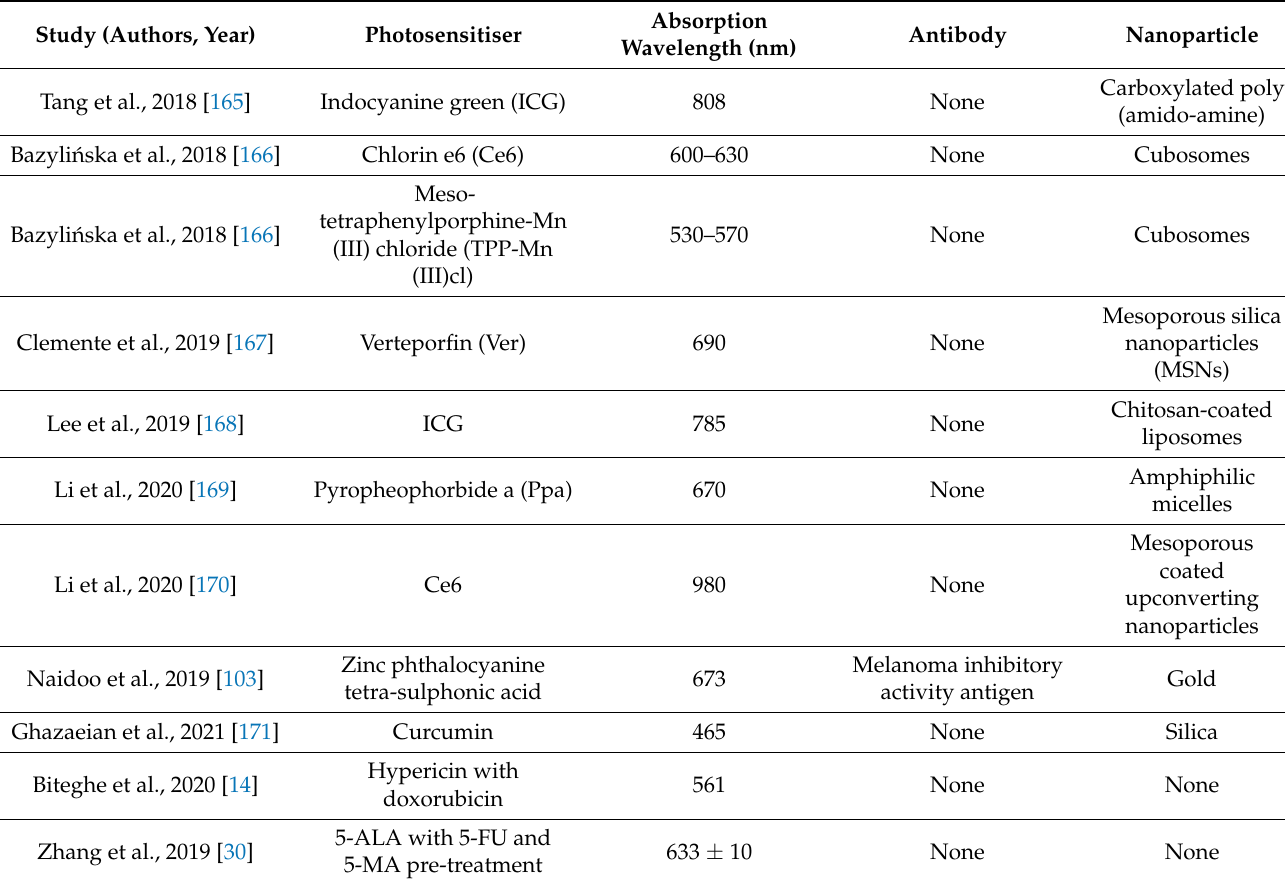
Table 2. List of photosensitisers under investigation for melanoma PDT (2018 to